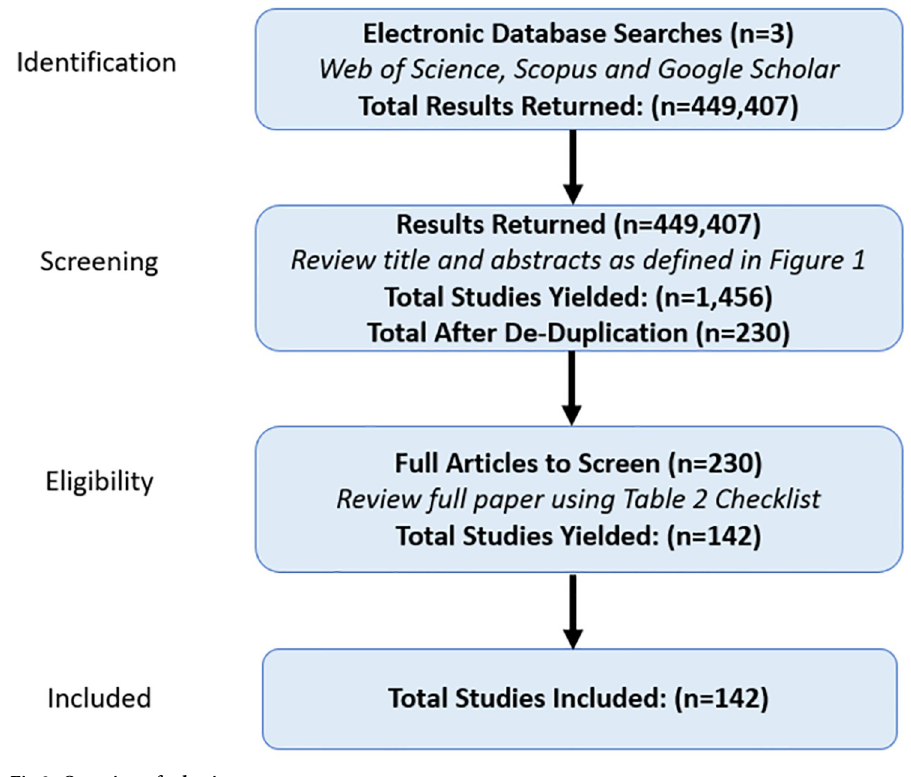
Fig 2. Overview of selection